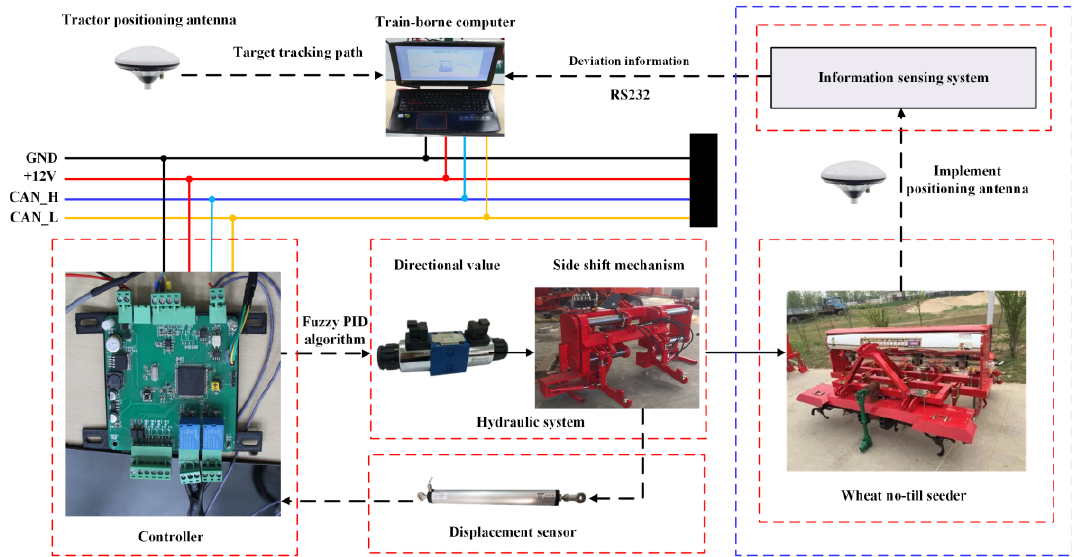
Figure 4. The hardware framework of the control system. Note: RS232 is the serial communication interface of the controller; GND is ground; +12V is the controller power supply voltage; CAN_H is the controller high level interface; CAN_L is the controller low level interface.